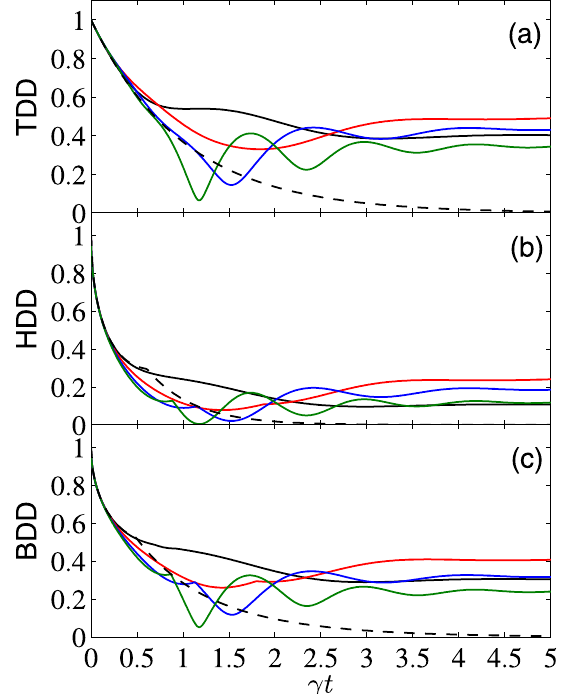
Figure 4. γ t dependence of TDD, HDD, and BDD (in units of J ) for the initial state φ + , with = n 0 , Δ = 1, and B = 0 (black solid), 0.8 (red solid), 1.6 (blue solid), and 2.4 (green solid). Moreover, the dashed curve shows the case of noninteracting qubits.